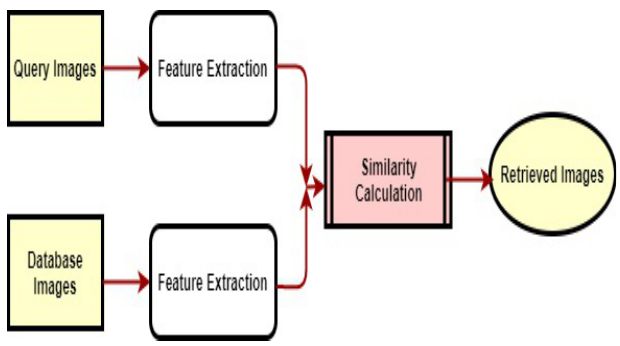
Figure 1. Block Diagram of a general CBIR